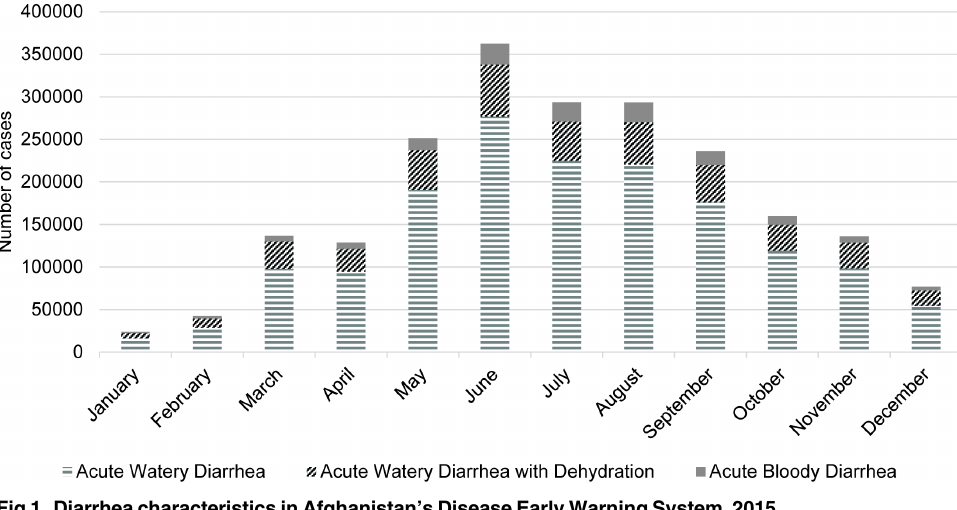
typhoid (17.2% of cases were < 5 years), and acute viral hepatitis (25.5% of cases were < 5 years. Diarrhea is a multifarious disease, and for the 46 weeks with data available, 73.3% of diarrhea cases were designated acute watery diarrhea, 20.4% acute watery diarrhea with dehy- dration, and 6.3% acute bloody diarrhea. The proportion of diarrhea with these symptoms also varied by season (Kruskal-Wallis Test p < 0.0001). There was a greater proportion of acute watery diarrhea and acute bloody diarrhea in the summer than other seasons, whereas the pro- portion of acute watery diarrhea with dehydration was greatest in the winter. Fig 1 shows the monthly distribution of these different types of diarrhea in 2015. Table 2 shows the long-term trends in the incidence of the six diseases, adjusted for seasonal cycles and the number of sentinel sites. Pneumonia and diarrhea did not deviate in incidence